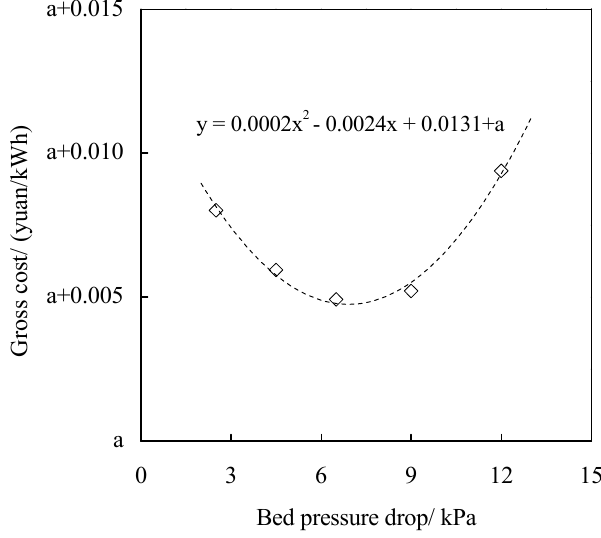
ff ect of bed pressure drop on gross Figure 15. Effect of bed pressure drop on gross cost. Figure 15. E